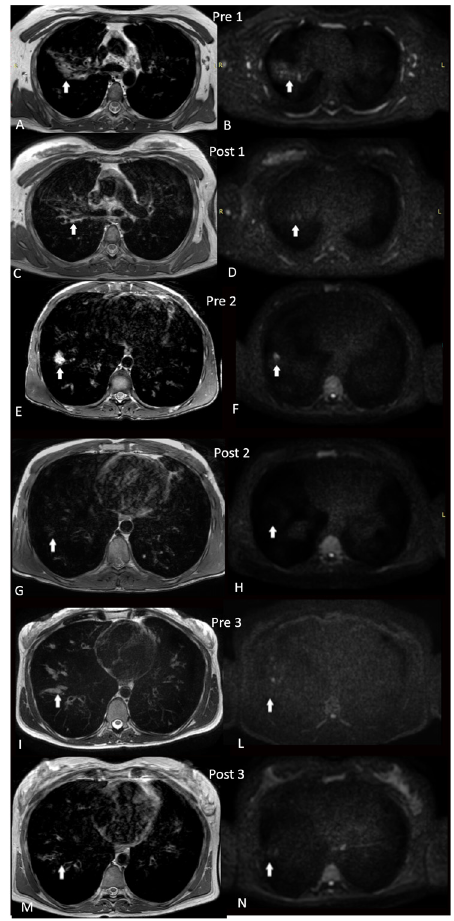
Figure 1. Patient 1, MRI images pre ELX/TEZ/IVA therapy: axial PD weighted image showing cilindric bronchiectasis with large amount of mucus plugging within and bronchial wall thickening ( A ). Atelectasis visible in the dorsal segment of the right upper lobe ( A ); DWIBS sequence at 800 b-value, with evidence of signal restriction in the mucus plugging ( B ). Patient 1, MRI images after 3 months of ELX/TEZ/IVA therapy: reduction in mucus plugging, and bronchial wall thickening ( C ); on DWIBS sequence at 800 b-value, no evidence of signal restriction ( D ). Patient 2, MRI images pre ELX/TEZ/IVA therapy: T2 axial image showing consolidation in the lateral segment of lower right lobe ( E ), with signal restriction in 800 b-value DWIBS ( F ). Patient 2, MRI images after 3 months of ELX/TEZ/IVA therapy: T2 axial image showing no consolidation ( G ) and no restriction in DWIBS sequence ( H ). Patient 3, MRI images pre ELX/TEZ/IVA therapy: PD weighted image, axial, showing evidence of mucus plugging on lateral segment of right lower lobe with bronchial wall thickening ( I ). Axial 800 b-value DWIBS sequence, showing signal restriction within the large mucus plugging ( L ). Patient 3, MRI images after 3 months of ELX/TEZ/IVA therapy: PD weighted axial, evidence of detersion of large airways mucus plugging of the bronchiectasis of the lateral segment of the lower right lobe, reduction in bronchial wall thickening ( M ). No evidence of signal restriction at 800 b-value DWIBS at the same level ( N ). Arrows were used to indicate the areas of interest.